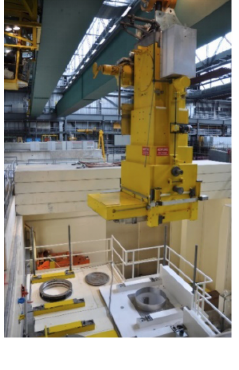
Figure 5. TgE remote- handling exchange flask lifted by the 60 t crane in Figure 6. Schematic of the target region. The two capture solenoids the HIPA facility experi- are collecting muons (black lines) sideways to mental hall.